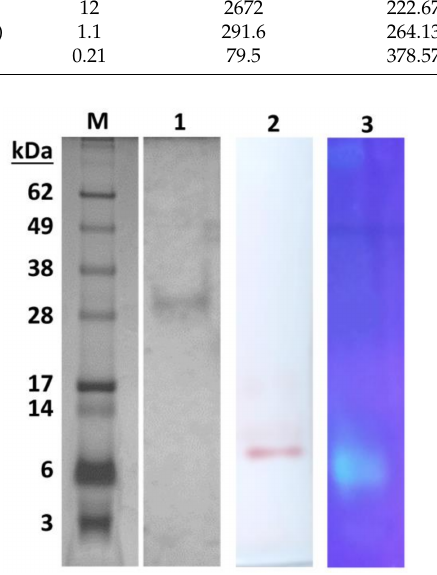
Figure 1. SDS-PAGE and zymogram analysis of the purified lipase from M. echinosphaera CBS 575.75. Lane M: See Blue Plus2 SDS-PAGE molecular weight standard (Life Technologies, Carlsbad, CA,